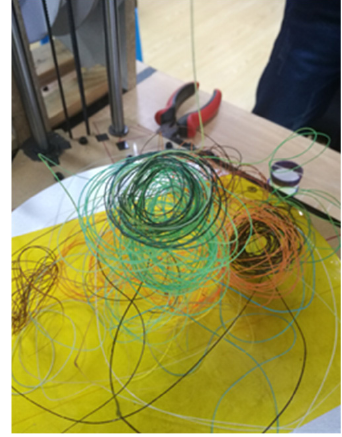
Figure 14. Extruded colored silk samples.